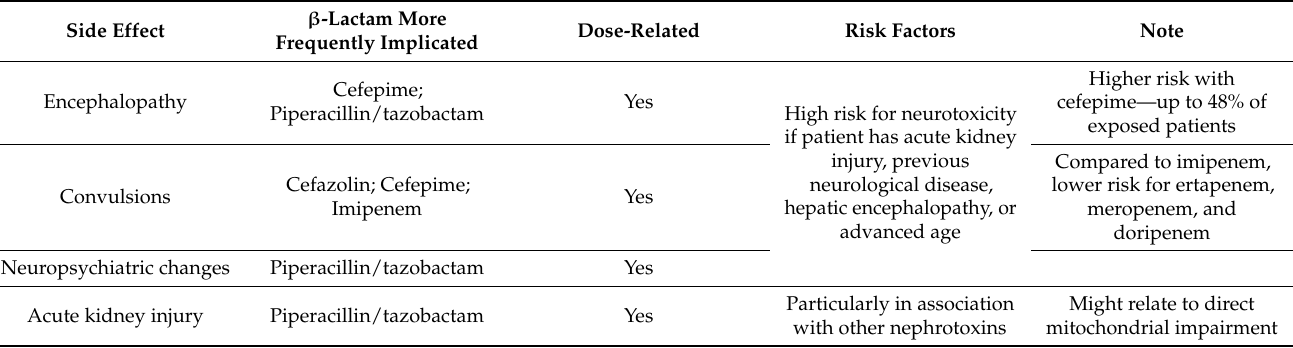
Table 2. β -Lactam-related adverse events.